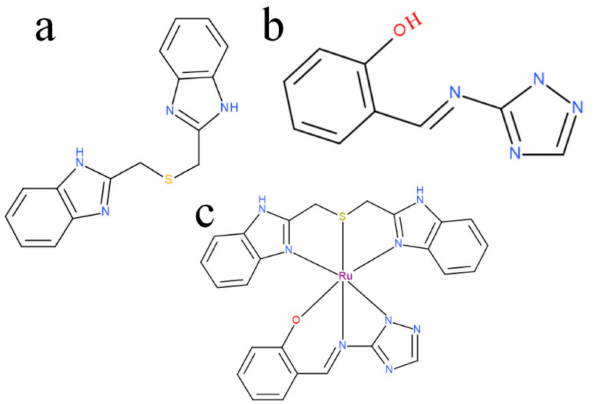
Figure 1. ( a ) benzimidazole ligand structure, ( b ) Schi ff base ligand structure, ( c ) possible structure of RU-S4.